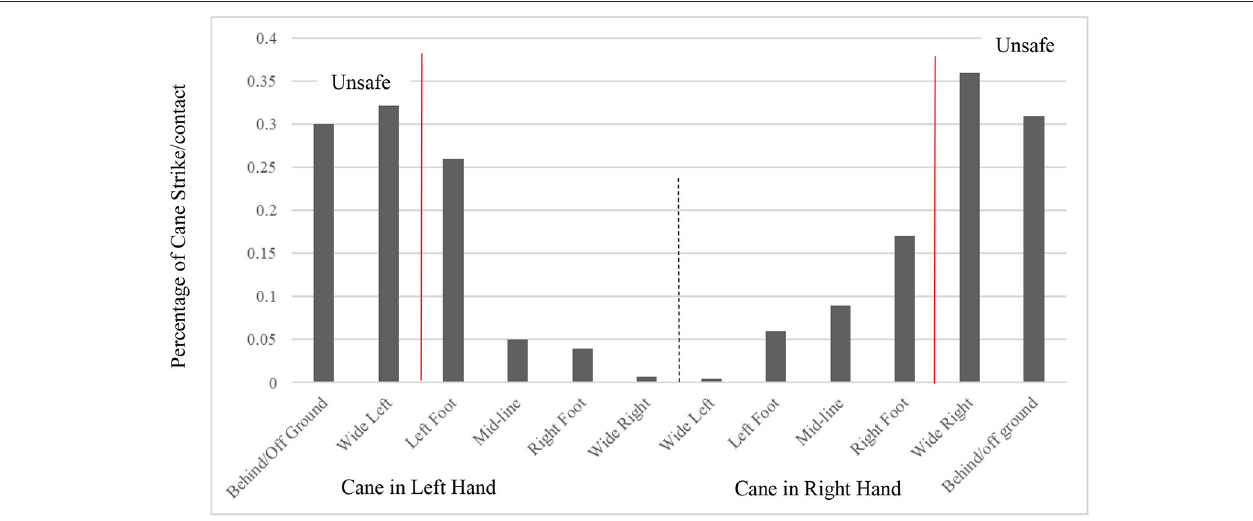
FIGURE 3 | Location of cane position. Cane tip position during 1,150 steps when long cane held in left hand ( n = 369 steps) and right hand ( n = 781 steps). The child’s cane motion positioned cane tip 65 percent of the time in an unsafe location on the cane hand side. The cane rarely (left hand, 4%; right hand, 6%) crossed mid-line to a position ahead of the opposite